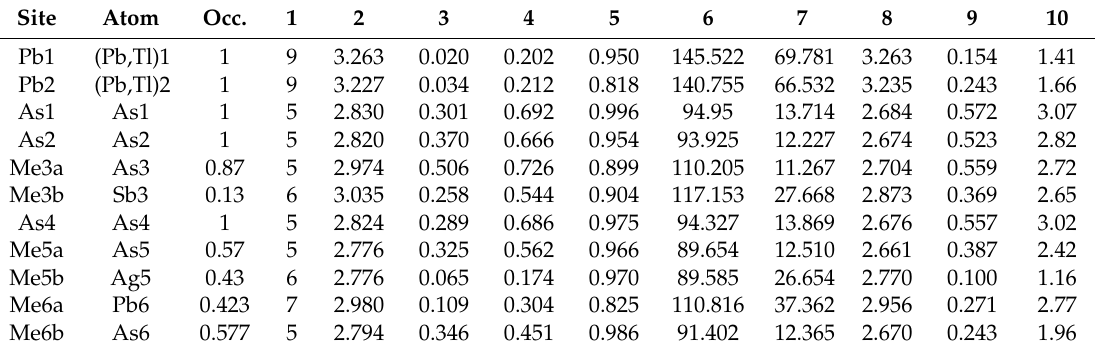
Table 12. Polyhedron characteristics for atoms in sample rath9 (for explanation of header numbers see Table 11).